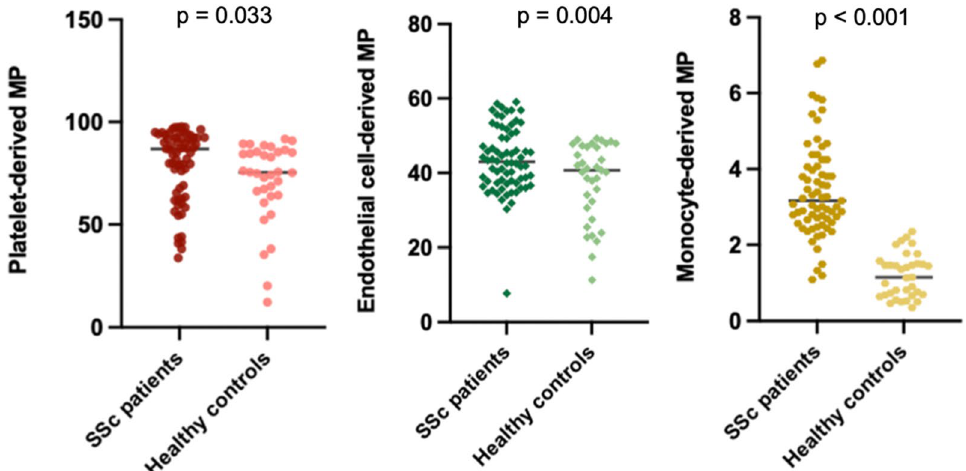
Fig. 2 Plasma levels of microparticles (MP) between patients with systemic sclerosis (SSc) and controls